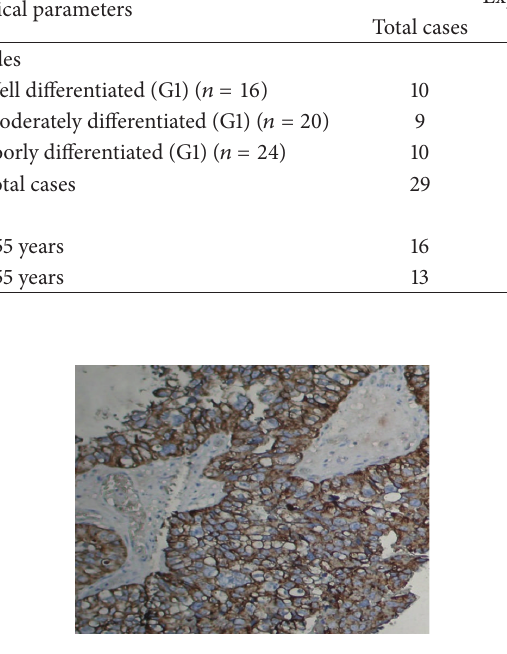
Figure 3: Cytokeratin (CK) expression in the cytoplasm of squa- mous cell carcinoma (Org. Mag. ×